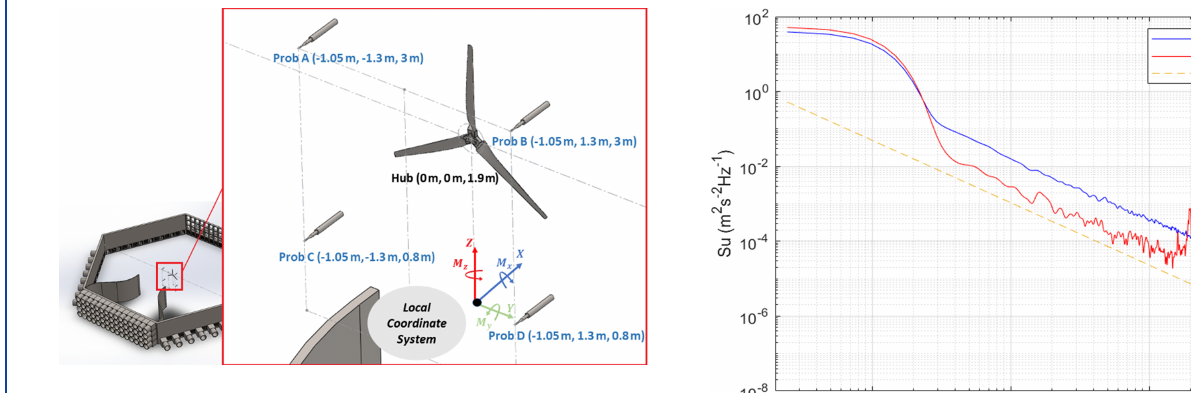
Figure 4. The arrangement of cobra probes and HAWT relative to the local coordinate system.